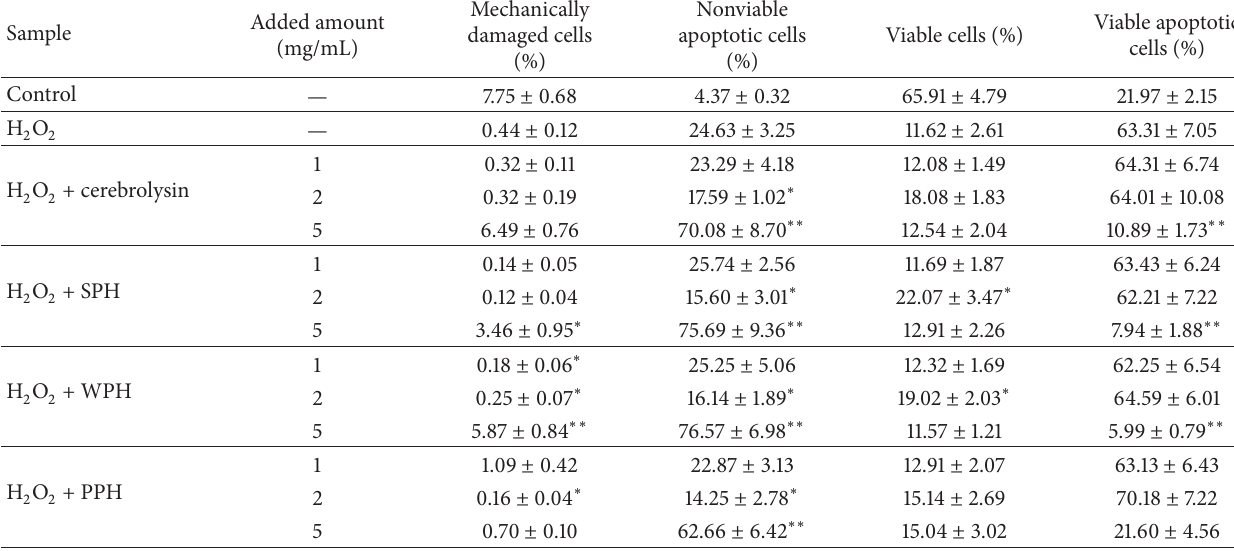
Table 2: Flow cytometry analysis for the neuroprotective effects of SPH, WPH, and PPH on H 2 O 2 -induced apoptosis in cultured PC12 cells. Sample